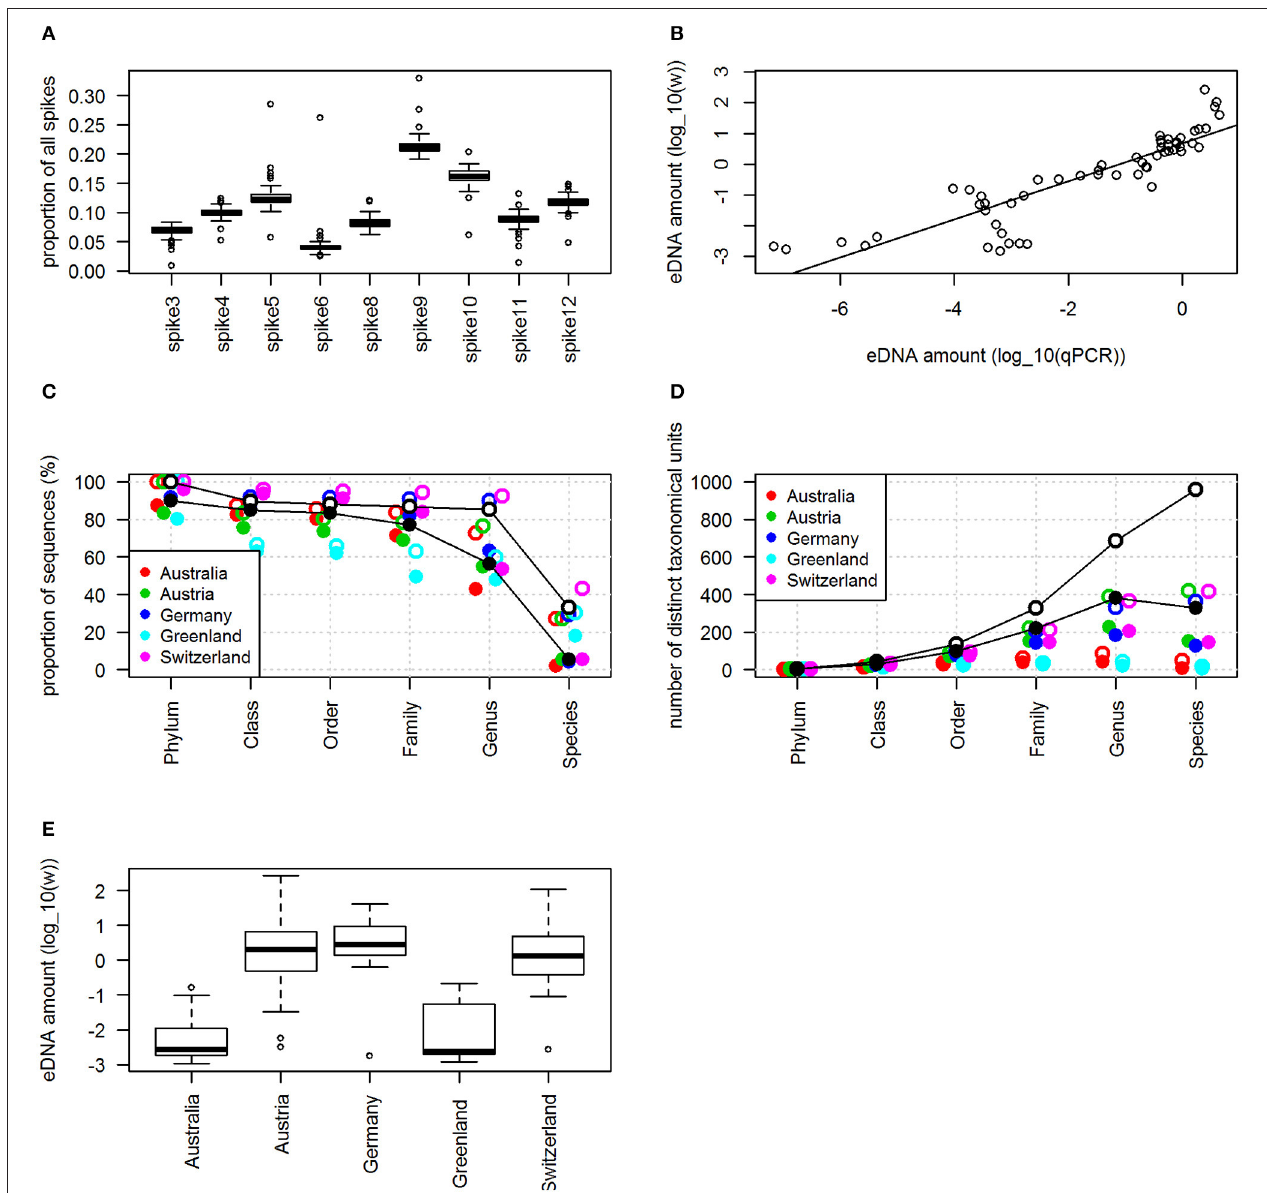
FIGURE 2 | Exploration of the pilot data. (A) Shows the relative spike proportions ˆ s ij . (B) Compares the amount of DNA as measured by qPCR (x-axis) to the sequencing-based measure w (y-axis), both log 10 -transformed ( R 2 of linear regression 0.79). (C) Shows the proportion of samples and (D) the number of distinct taxa that could be identified at each taxonomic level. In (C,D) open circles refer to plausibly identified taxa (probability of correct taxonomic placement > 50%), whereas closed dots refer to reliably identified taxa (probability of correct taxonomic placement > 90%). In (C,D) black circles represent pooled samples, and other colors to locations-specific samples. (E) Shows the amount of DNA, measured by log 10 w i , with samples sorted by location.